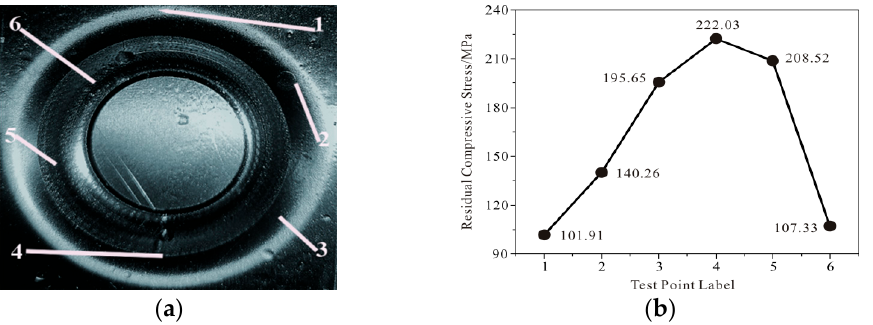
Figure 5. Residual compressive stress of the 2D-UVIF part. ( a ) Locations of residual stress testing points. ( b ) Residual compressive stress curve. 2D-EUVIF is the abbreviation for 2D ellipse ultrasonic vibration incremental forming. (Notes: The numbers 1–6 accordingly represent six testing points located on the inside wall of the conical part.).